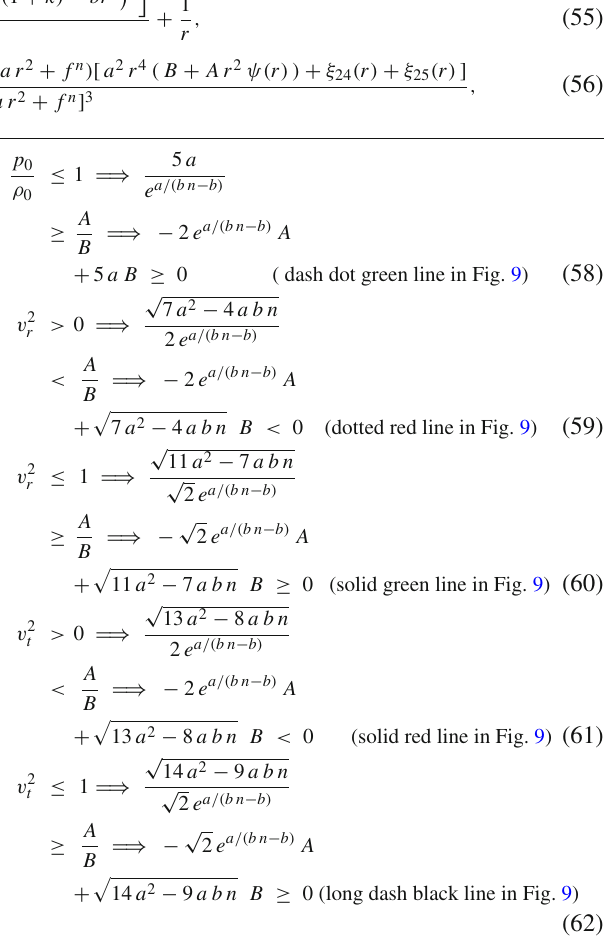
To plot the Fig. 9 we have fixed the values of constant parameters a , b and n and form a set of linear constraints for two unknowns A and B . From Fig. 9, we can observe that the linear constraints (60)–(61) shows the common region (shaded by yellow color) where all the physical conditions will preserve for n = 4. It is to note that the common region will always preserve between the constraints (60)–(61) for all different values of n which can be shown by a similar